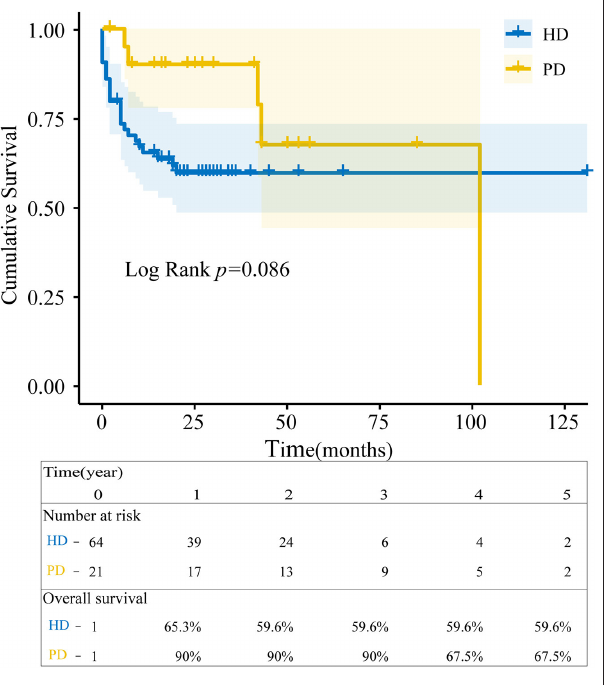
FIGURE 1 | Overall survival estimates since dialysis initiation. The blue line represented patients with ANCA-associated vasculitis end-stage renal disease (AAV-ESRD) receiving hemodialysis (HD) and the yellow line with peritoneal dialysis (PD). Survival between HD and PD patients was analyzed by the Kaplan-Meier method using R language ( p =